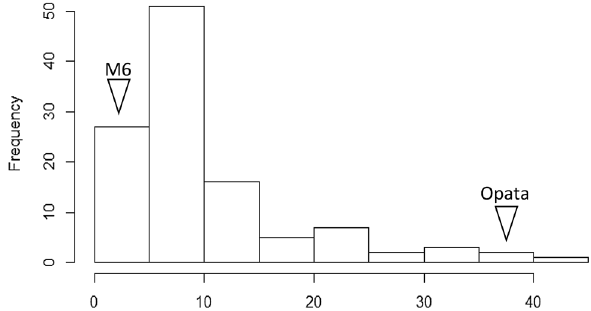
Figure 1. Frequency distribution of doubled haploid (DH) lines for cysts